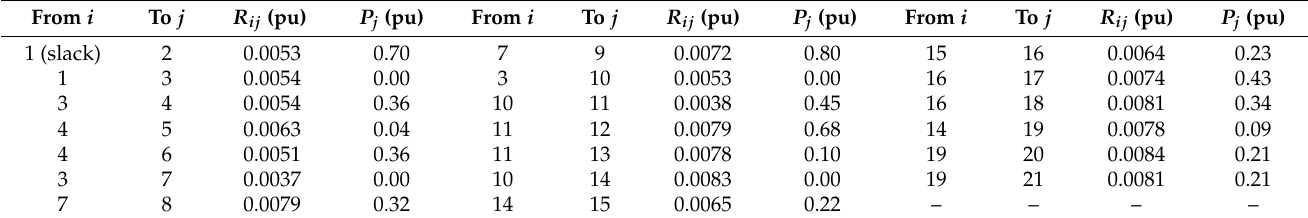
Table 2. Data for the 21-bus